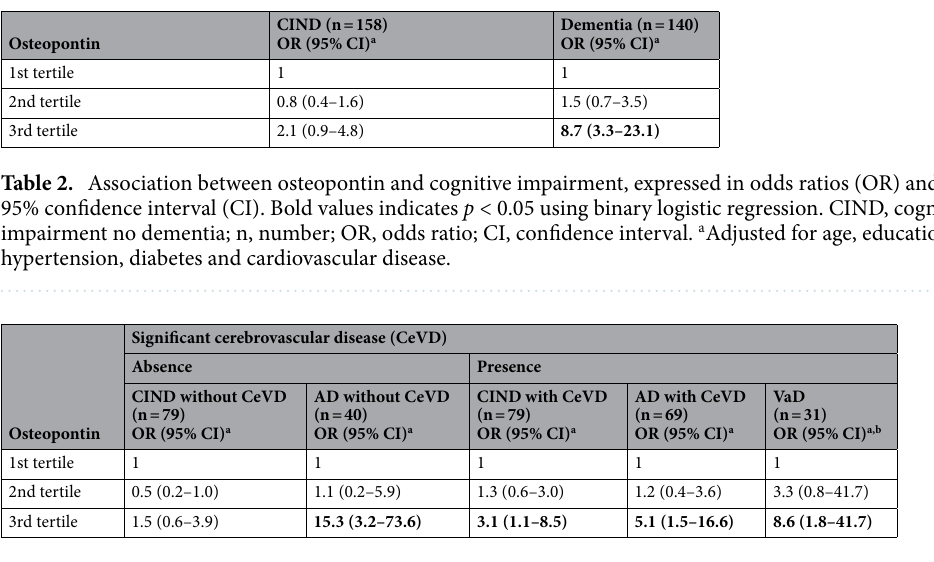
Table 3. Association between osteopontin and cognitive impairment stratified by presence of significant cerebrovascular disease (CeVD), expressed in odds ratios (OR) and 95% confidence interval (CI). Bold values indicates p < 0.05 using binary logistic regression. Abbreviations: CeVD, cerebrovascular disease; CIND, cognitive impairment no dementia; AD, Alzheimer’s disease; VaD, vascular dementia; OR, odds ratio; CI, confidence interval. a Adjusted for age, education, hypertension, diabetes and cardiovascular disease. b Estimated using Firth logistic regression due to separation where hypertension perfectly predicts VaD.